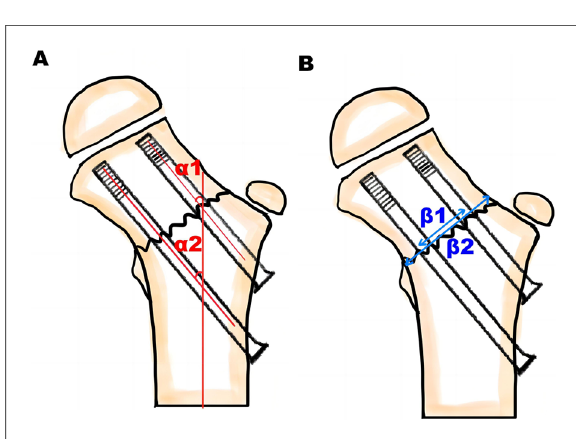
FIGURE 5 Evaluate the screw parallelism and screw distribution. ( A ) The shaft screw angle ( α ) was de fi ned as the angle between the femoral shaft axis and the longitudinal axis of each screw. ( B ) The screw distribution was de fi ned as the relative coverage of the neck width, which was calculated as the product of the distance between the borders of the outer screws at the fracture line divided by the neck width at the fracture